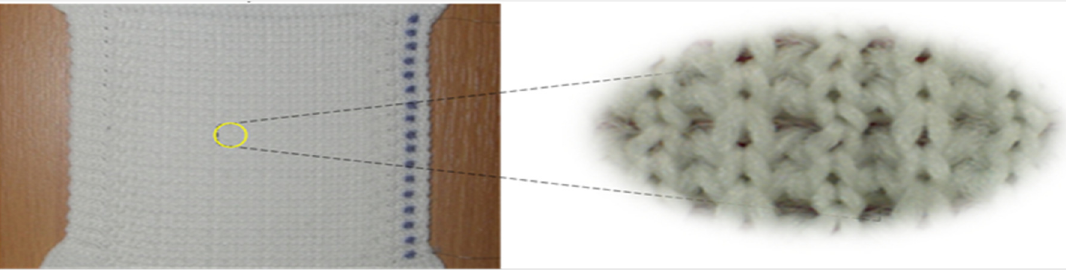
Fig. 2: A TSF sample of 8cm x 8cm sensing region along with a microscopic view of the fabric structure